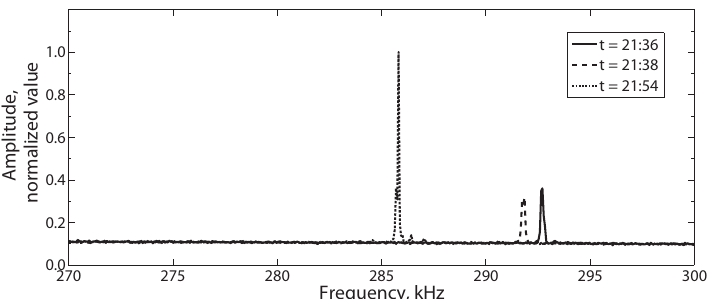
Fig.2. The autocorrelation spectra calculated at 21:36 UT (solid line), 21:38 UT (dashed line) and 21:54 UT (dotted line). Integration time: 0.016 s. Irbene, 2013 February 15.